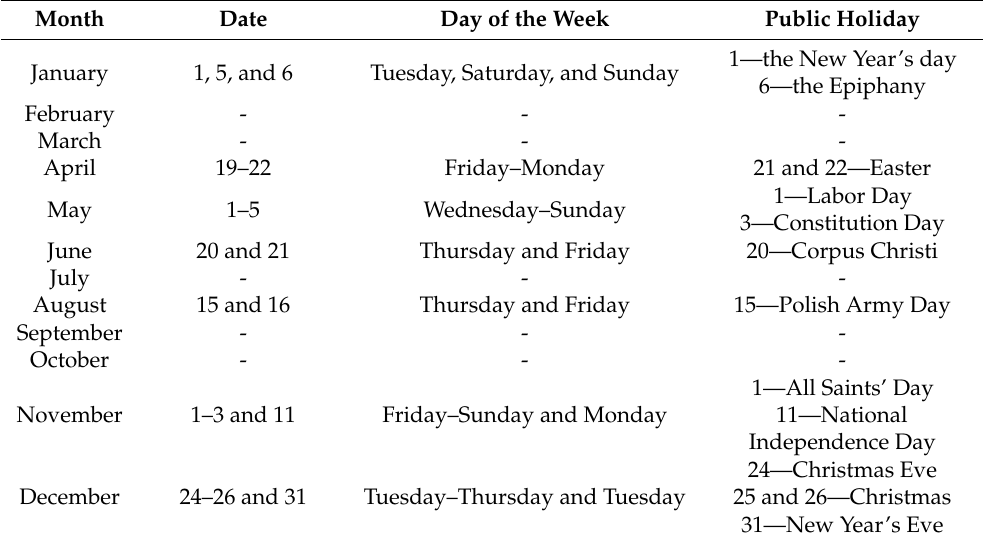
Table 1. List of days on which a decrease in value is noticeable to the corresponding days in particular months of 2019, along with information about public holidays occurring on those days.